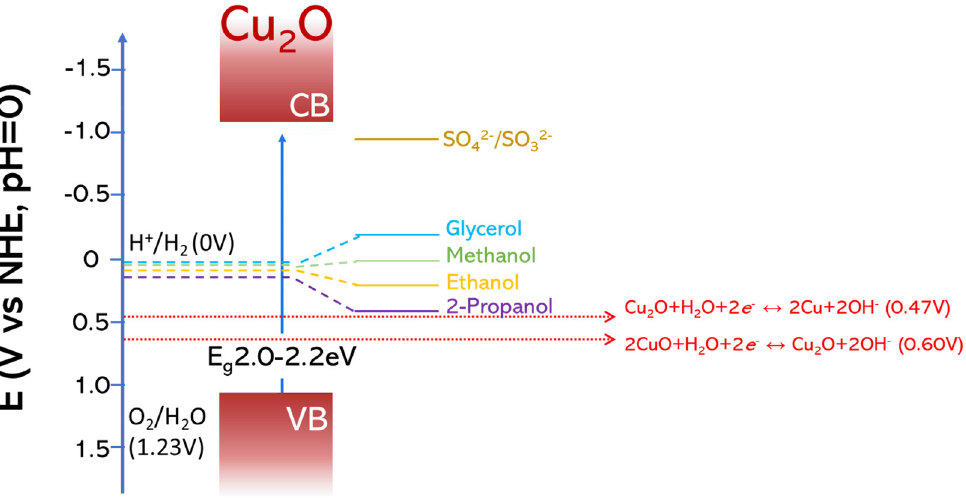
Figure 4. The redox-potential of some commonly used organic hole-scavengers as well as of SO 3 2 − : the more negative potential of the SO 4 2 − /SO 3 2 − couple can provide a more efficient protection against self − photo − oxidation of Cu 2 O [31,41].